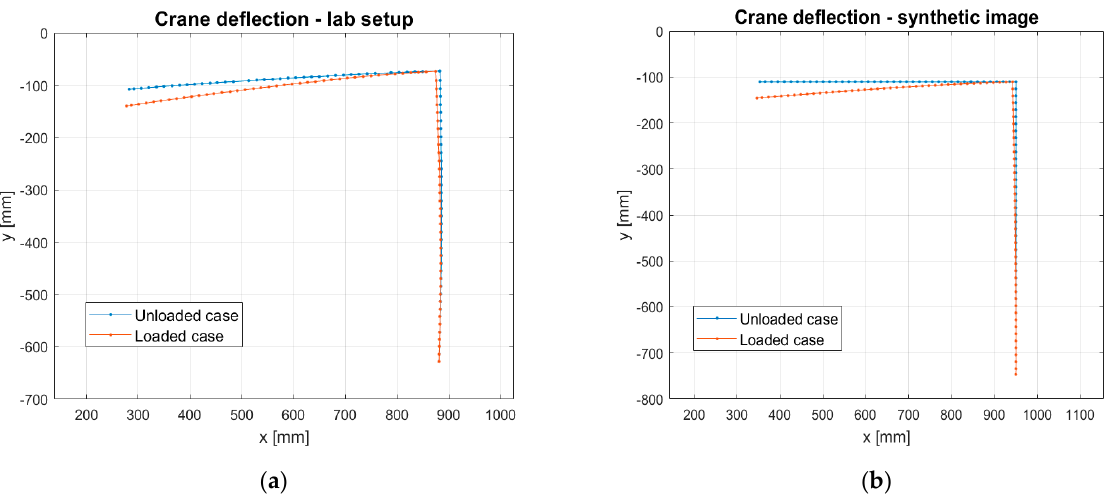
Figure 6. Results of the comparison of the tower crane deflection lines for the experimental data ( a ) and for the FEM + Blender ( b ) simulation (renders).